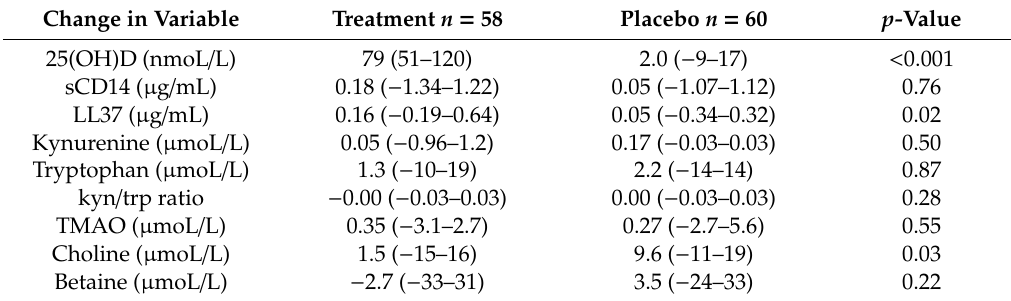
Table 4. Di ff erence in outcomes in vitamin D insu ffi cient individuals in treatment and placebo Table 4. Difference in outcomes in vitamin D insufficient individuals in treatment and placebo arm.